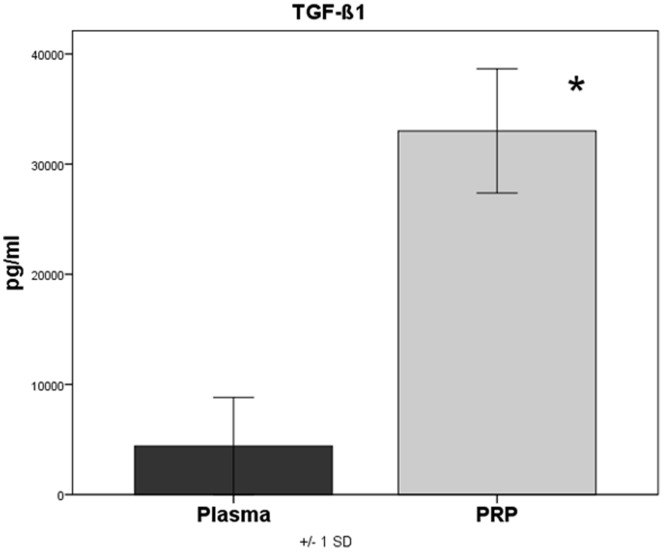
Quantification of TGF-β1 in plasma and PRP, p<0.001 PRP versus plasma.